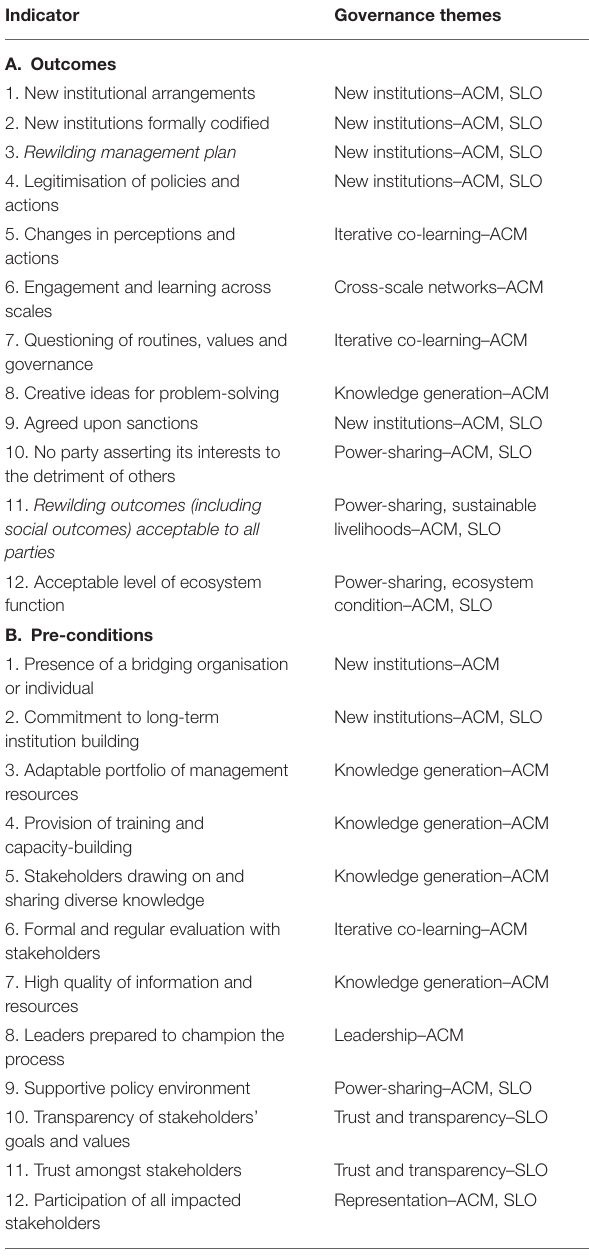
TABLE 1 | Proposed indicators for evaluating (A) rewilding governance outcomes and (B) pre-conditions for ongoing adaptive governance, showing alignment with ACM and SLO themes, adapted from Butler et al.